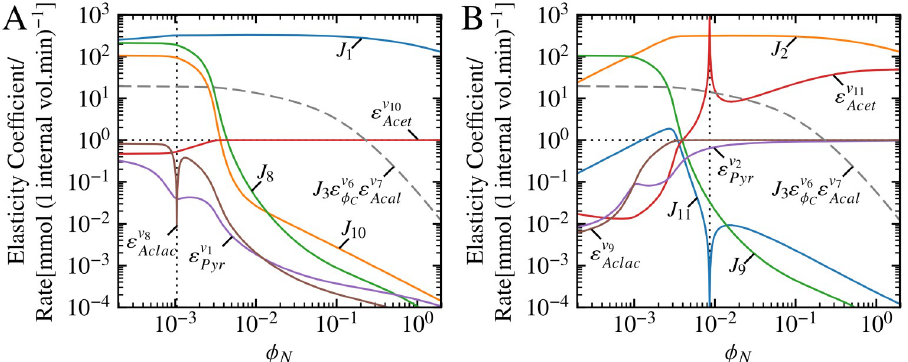
Fig 8. The flux and elasticity components of T 1 × A and T 6 × C as functions of ϕ N . (A) The elasticity and flux factors that constitute the multiplier T1 and backbone A. (B) The elasticity and flux factors that constitute the multiplier T6 and backbone C. Both T1 × A and T6 × C share the factor J , which is indicated as a single dashed ε v 6 � ε v 7 3 Acal C grey line in each of (A) and (B). Logarithmic coordinates together with a horizontal black dotted line and absolute values are used in the same fashion as in Fig 4. The the black vertical dotted line in (A) indicates crossover from positive to negative values of ε v 8 (due to product activation as a result of cooperative product binding in the Aclac reversible Hill equation [46]) and in (B) indicates the crossover from positive to negative values of J 11 and ε v 11 Acet